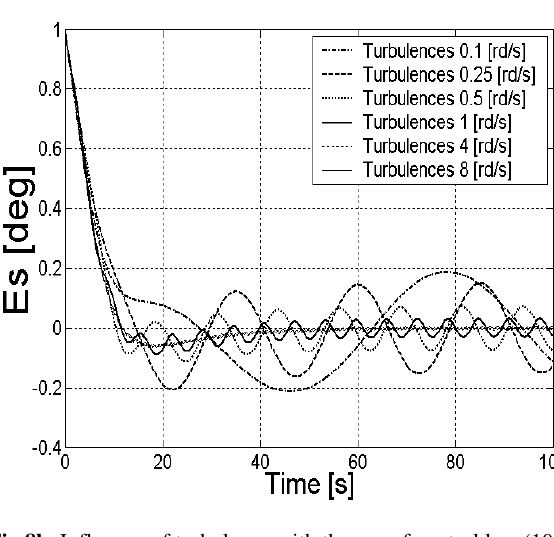
Fig 8b. Influence of turbulence with the use of control law (10)